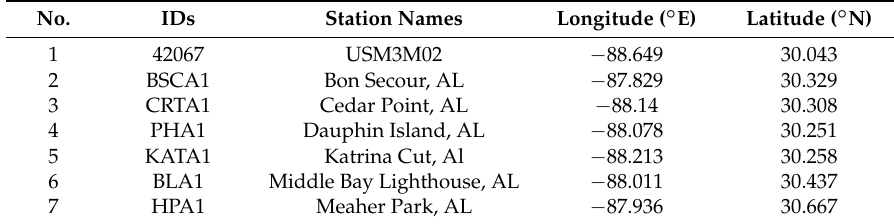
Table 3. Station meta data of surface salinity observations.